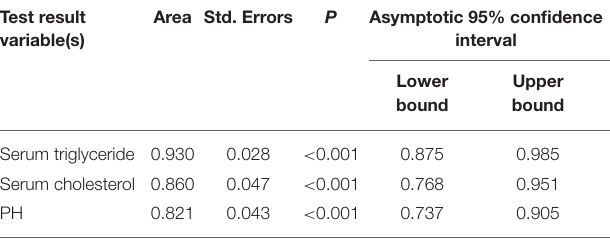
TABLE 4 | Different indicators for the prediction of the DKA patients with AP.